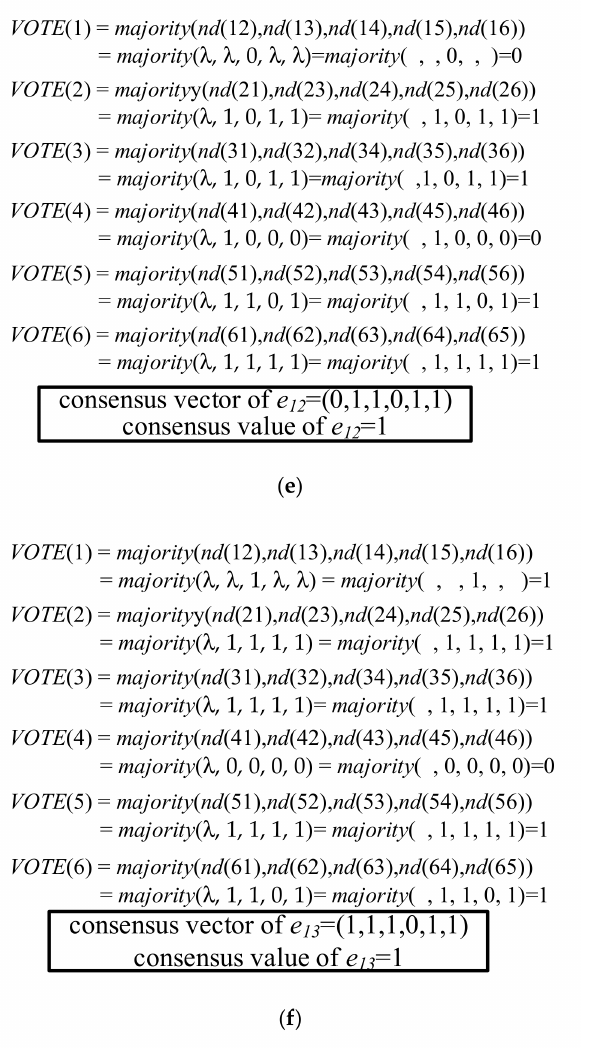
Figure 8. ( a ) The initial value of each PE in Edge cloud E 1 of Edge-layer. ( b ) The dg-graph of each PE in Edge cloud E 1 during the first data exchange in the Data Gathering Stage. ( c ) The final dg-graph of e 12 during the second data exchange in the Data Gathering Stage. ( d ) The final dg-graph of e 13 during the second data exchange in the Data Gathering Stage. ( e ) The consensus value of e12 by Consensus Decision Stage. ( f ) The consensus value of e13 by Consensus Decision